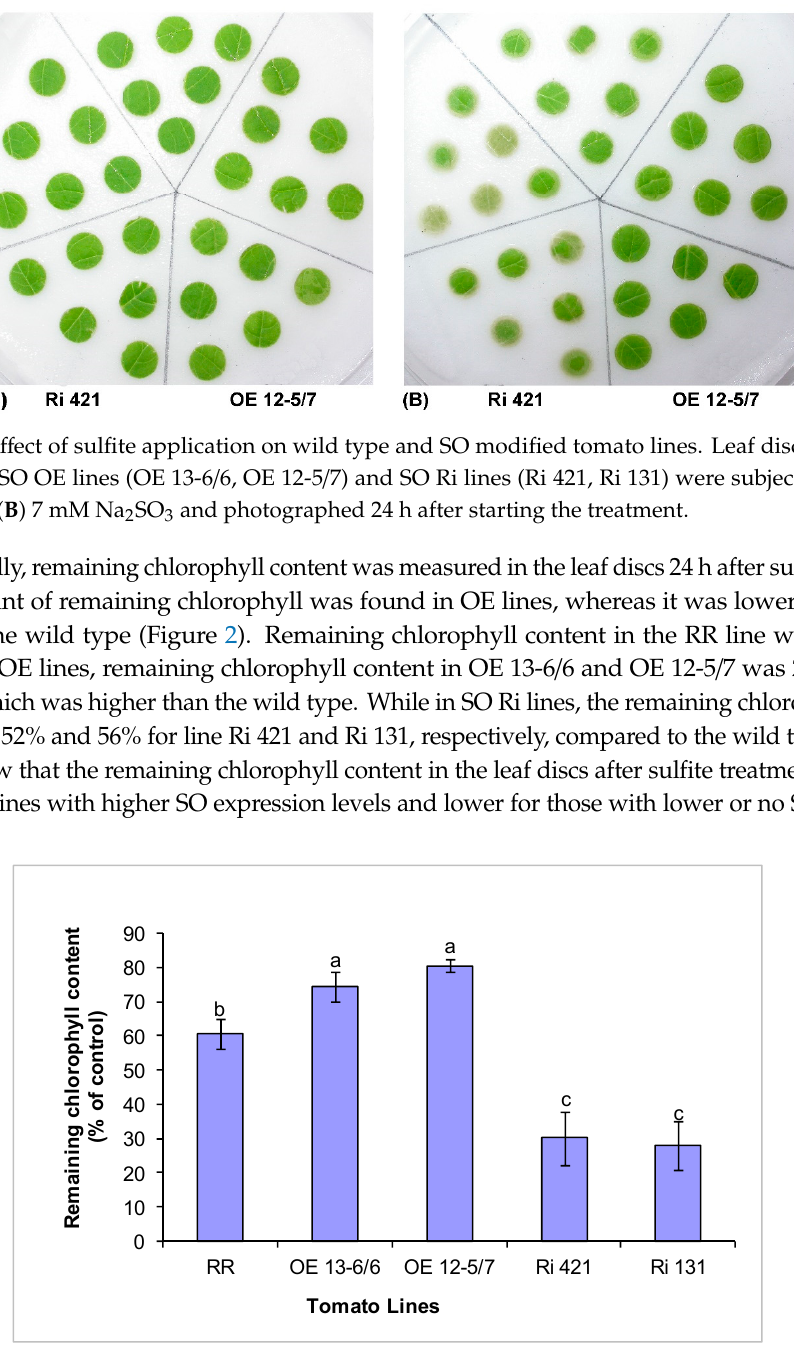
Figure 2. Remaining chlorophyll in wild type and SO modified tomato plants after sulfite treatment. Leaf discs from wild type (RR) and SO OE (OE 13-6 / 6 and OE 12-5 / 7) and SO Ri (Ri 421 and Ri 131) tomato lines were subjected to 0 mM (control) and 7 mM Na 2 SO 3 for 24 h. The remaining chlorophyll content was expressed in percentage of control. Values are means ± SE ( n = 5). Means denoted with di ff erent letters were significantly di ff erent ( p <